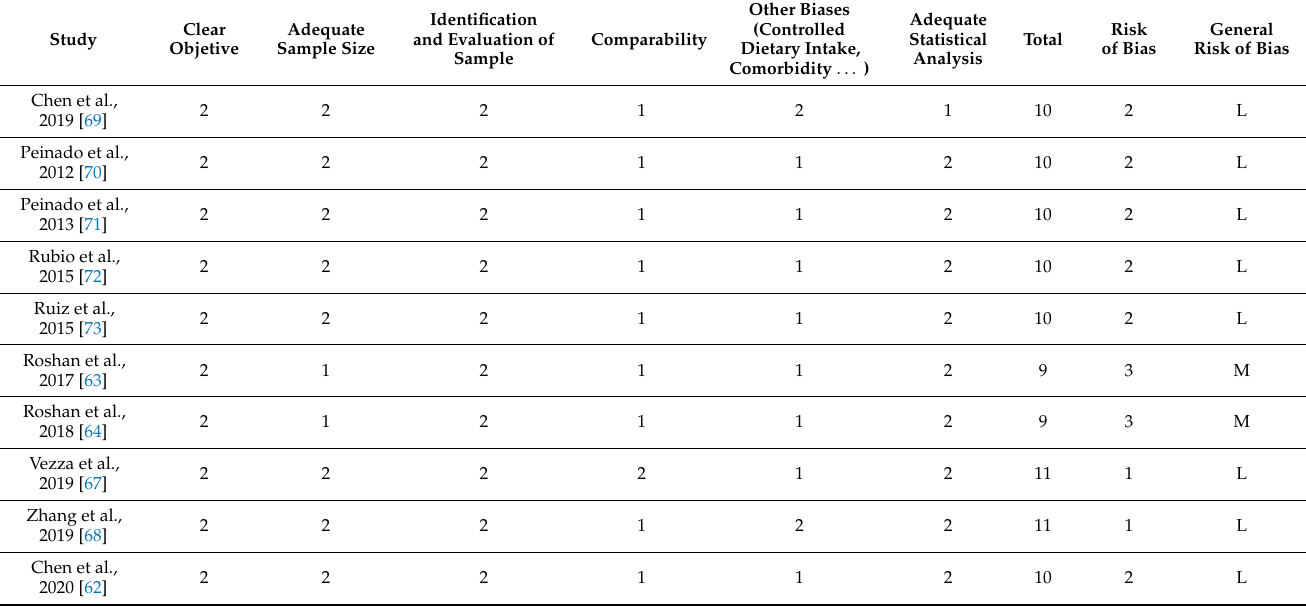
Table 2. Risk of bias for the methodological quality of studies on organosulfur compounds and gut microbiota.